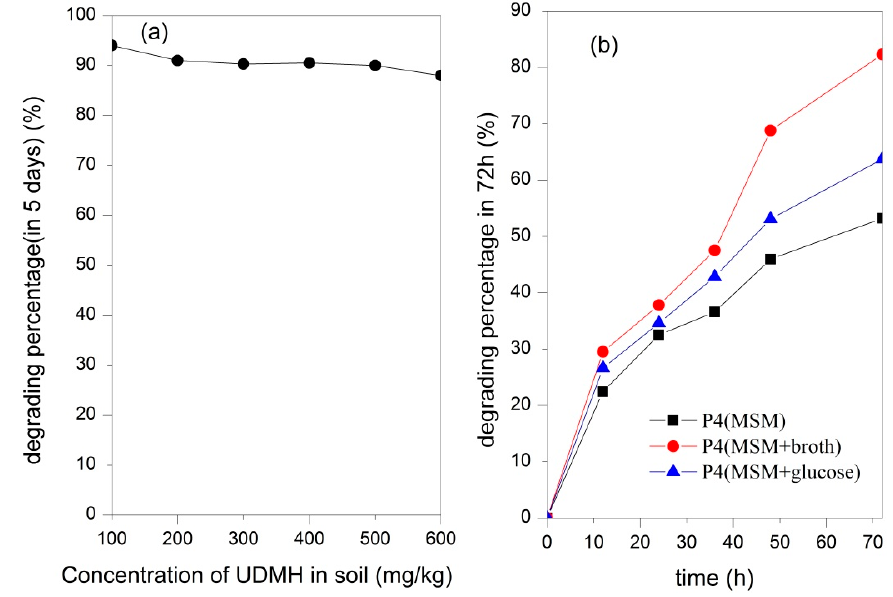
Figure 8. The influencing factors on UDMH degradation for P4: ( a ) the concentration of UDMH in soil; ( b ) the extra carbon source in MSM.